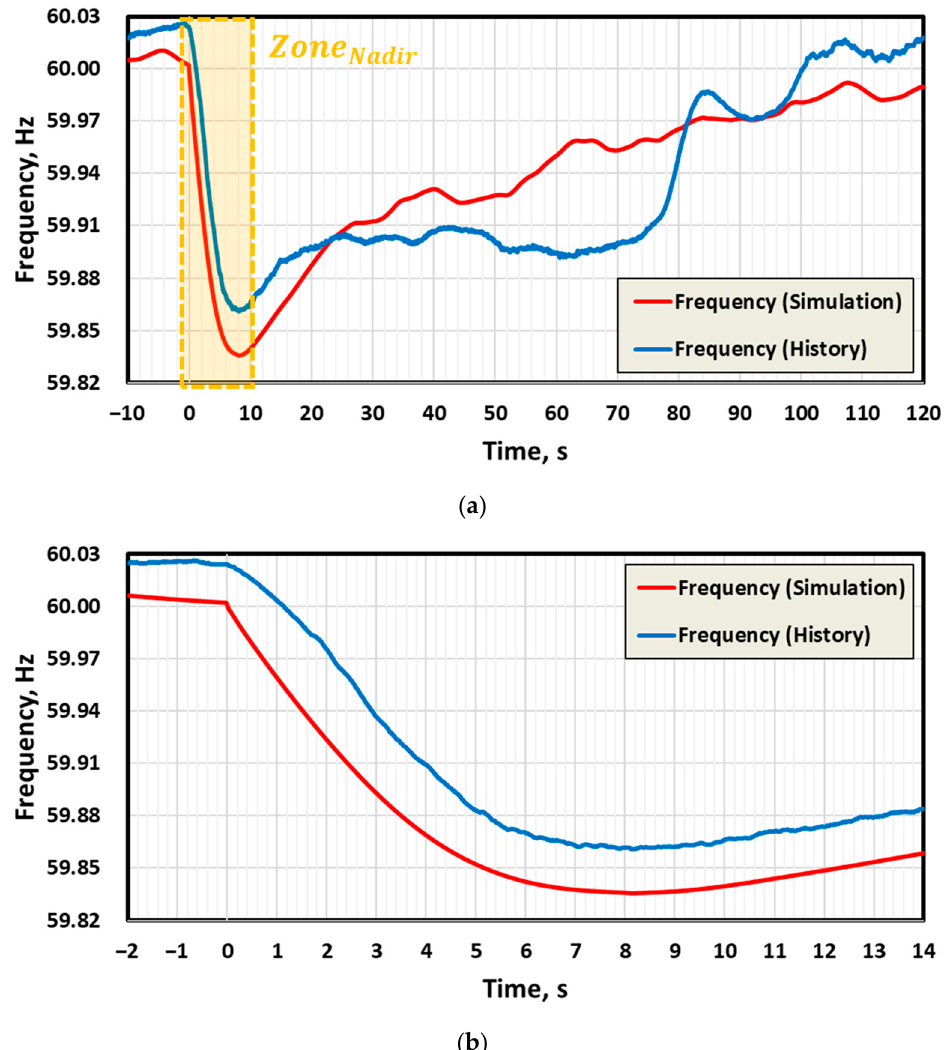
Figure 8. Comparison of history and simulation frequency for verification; ( a ) Frequency transient state until recovering to rated frequency; ( b ) Frequency transient state until nadir frequency point.